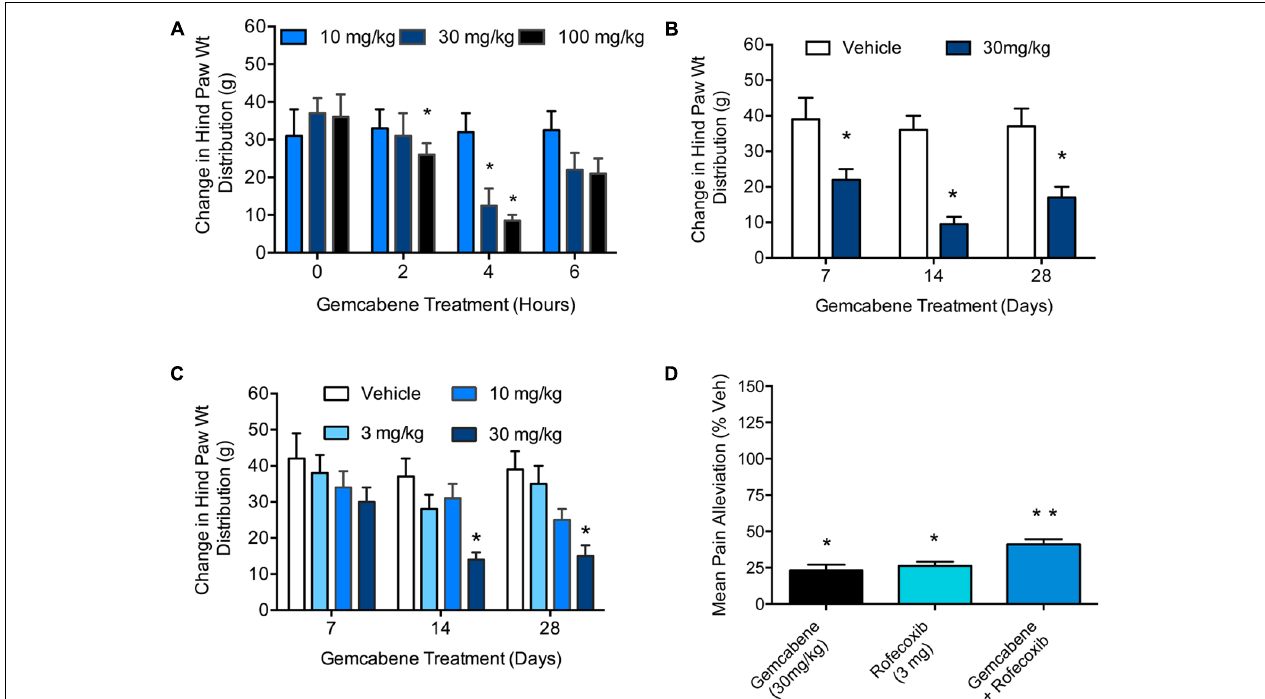
FIGURE 5 | Effect of gemcabene on monosodium iodoacetate (MIA)-induced change in hind paw weight distribution. (A) MIA was injected into the right knee and saline into the left knee of all rats on Day 0. On day 14 the rats were assessed on an incapacitance tester and then given gemcabene (10, 30, or 100 mg/kg, po). Two, 4, and 6 h later, the rats were reassessed. Statistically significant differences were determined by one-way ANOVA followed by Dunnett’s multiple comparisons procedure. Data are expressed as mean ± SEM, N = 8 rats per group. (B) MIA and saline were injected on day 0. Gemcabene (30 mg/kg) was given p.o., 0.5 h before MIA injection. Gemcabene was then given b.i.d for 28 days. Changes in hind paw weight distribution were determined on Days 7, 14, and 28. Statistically significant differences were determined by one-way ANOVA with the Dunnett’s multiple comparisons procedure ( ∗ p < 0.05). Data are expressed as mean ± SEM. N = 12 rats per group. (C) 28 days dose-response study. MIA and saline were injected on day 0. Gemcabene (3, 10, or 30 mg/kg) was given PO, 0.5 h before MIA injection. gemcabene was then given b.i.d for 28 days. Changes in hind paw weight distribution were determined on days 7, 14, and 28. (D) Rats were treated with MIA as shown in A for 14 days followed by acute treatment with the reference agents. Only 4 h time points are shown. Data presented show pain alleviation compared to vehicle control (100% pain, 0% comfort). Statistically significant differences were determined by one-way ANOVA with the Dunnett’s multiple comparisons procedure ( ∗ p < 0.05). Data are expressed as mean ± SEM. N = 12 rats per group. ∗∗ p <